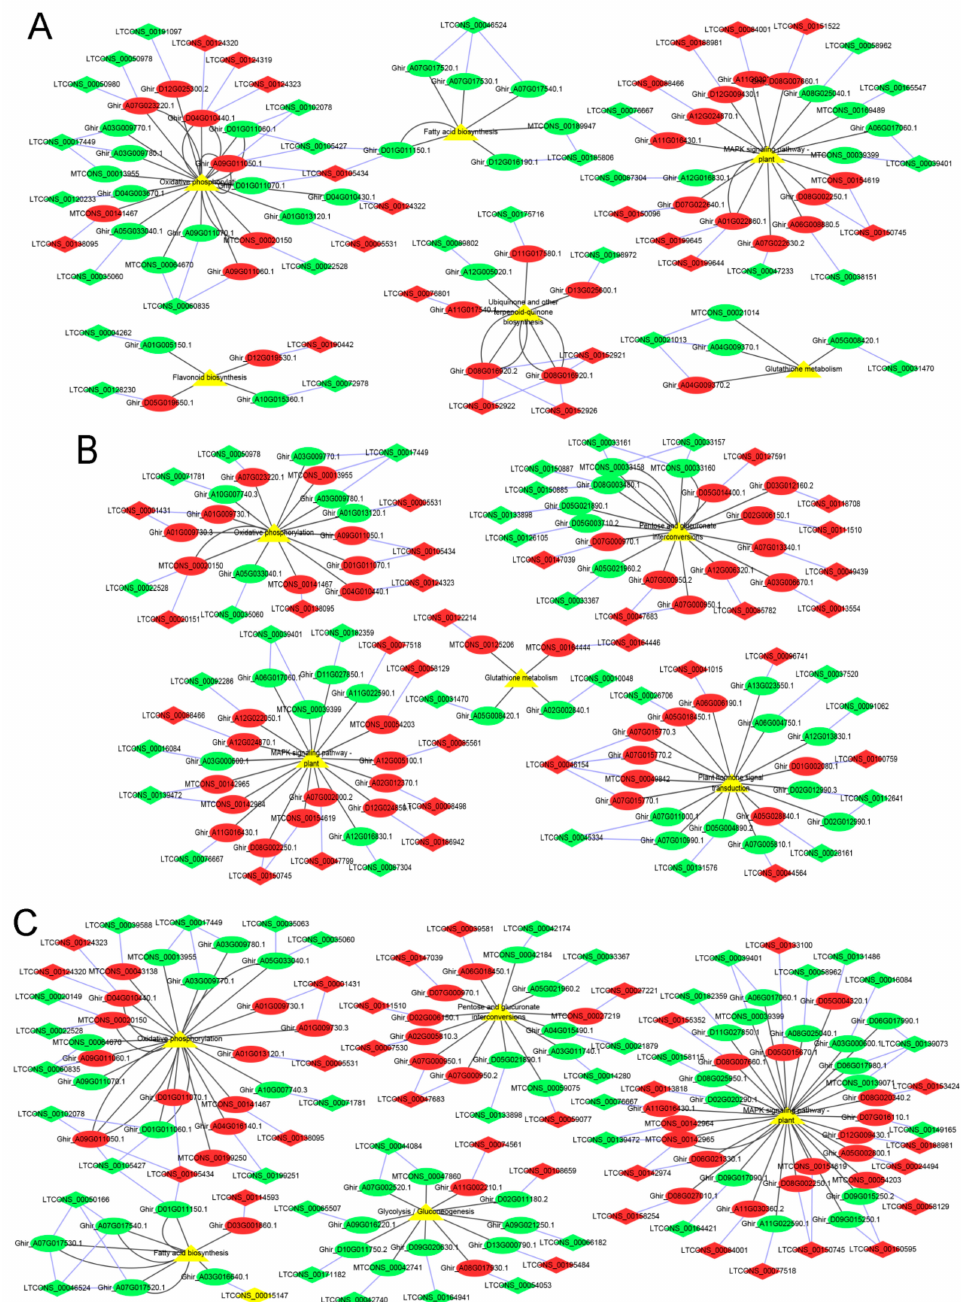
Figure 6. Kyoto Encyclopedia of Genes and Genomes pathways (KEGG) enriched for lncRNA–potential cis -target genes of anther development, between the cytoplasmic male sterility line C2P5A, and the maintainer line C2P5B. ( A ) KEGG pathways enriched for the Pms stage lncRNAs–mRNAs. ( B ) KEGG pathways enriched for the Tds stage lncRNAs–mRNAs. ( C ) KEGG pathways enriched for the Ms stage lncRNAs–mRNAs. The ellipse, diamond, and triangle nodes represent the mRNAs ( cis -target genes), lncRNAs, and pathway, respectively. Red represents upregulated, green represents downregulated, and yellow represents the enrichment of pathways. The blue edges showed interaction between the mRNA and lncRNA. The black edges showed regulatory interaction transcriptomes and pathways. At the Tds stage, 592 cis -target genes of lncRNAs were significantly enriched for NADH dehydrogenase (ubiquinone) activity, cytoplasm, and pectinesterase activity (Figure 5B and Table